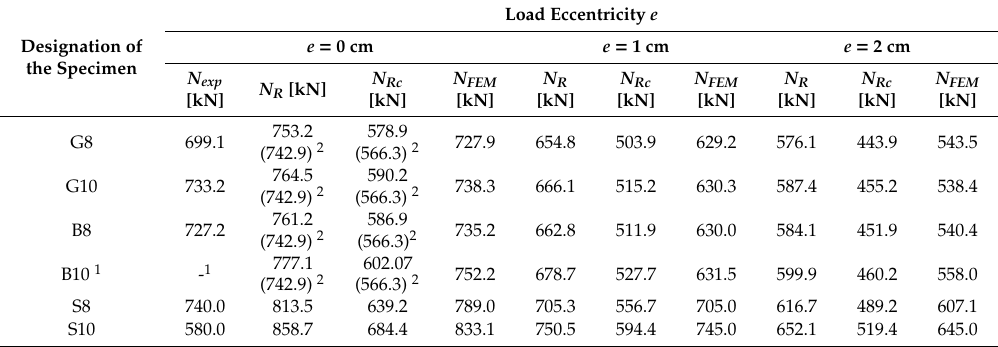
Table 4. The influence of load eccentricity and characteristic values of materials’ parameters on the calculated failure